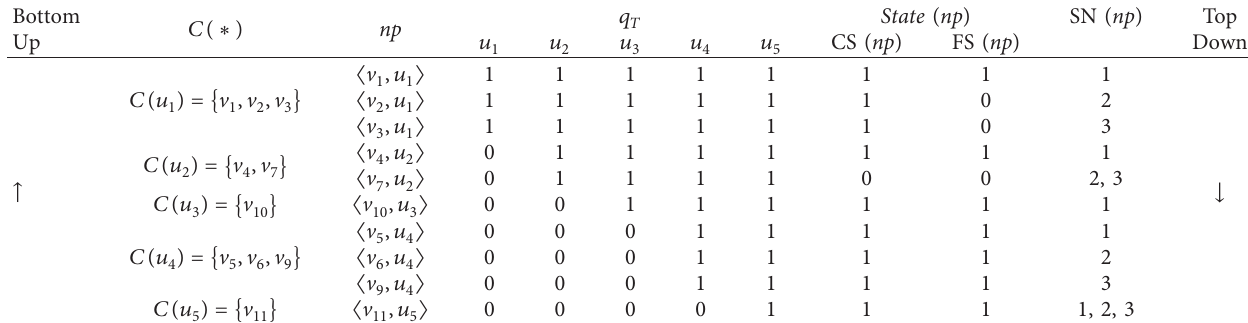
Table 3: An example of FG construction algorithm.